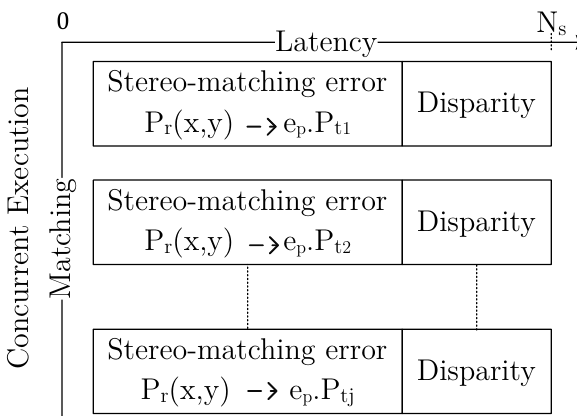
Figure 12. Spatial parallelization during stereo-matching.